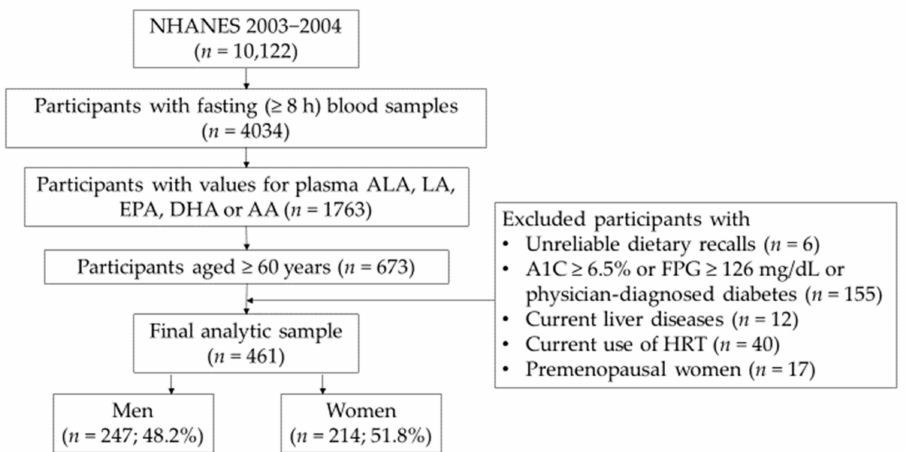
Figure 1. Flow chart of participant selection for the study population, NHANES 2003–2004. n , unweighted sample sizes; %, sample-weighted percentage; A1C, hemoglobin A1C; FPG, fasting plasma glucose; HRT, hormone replacement therapy; NHANES, National Health and Nutrition Examination